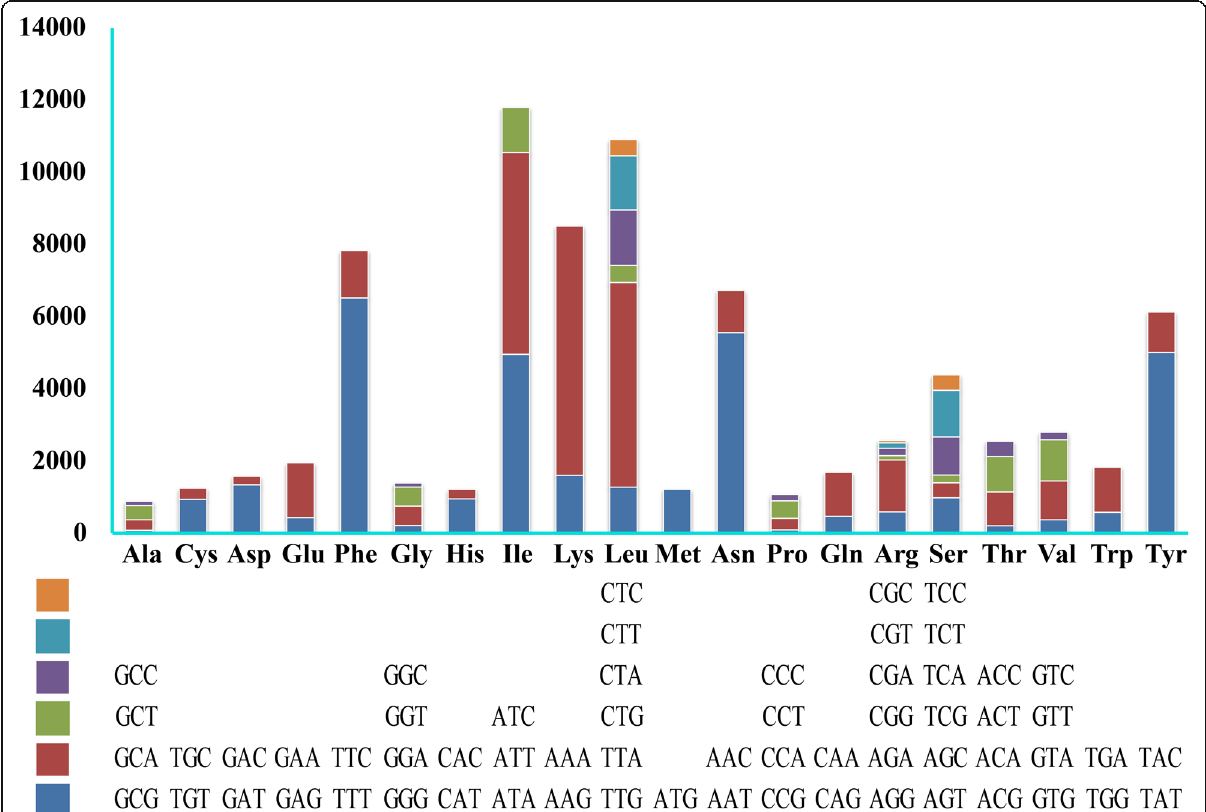
Fig. 3 Codon usage in the mitochondrial genome of Clavaria fumosa . Frequency of codon usage is plotted on the